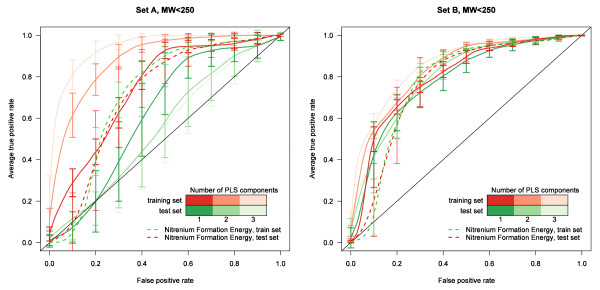
Averaged ROC curves of PLS models for aryl-amine sets (MW < 250 g/mol). Performance using 1, 2, or 3 components using 100 randomly sampled test and training sets is shown with Set A on the left and Set B on right. The darker shades of lines have fewer components (see scale) and the green ROC curves are for the 100 random test sets (30% sample) and the red for 100 training sets (remaining 70% of set) both averaged over identical false positive rates. Error bars represent standard deviation.